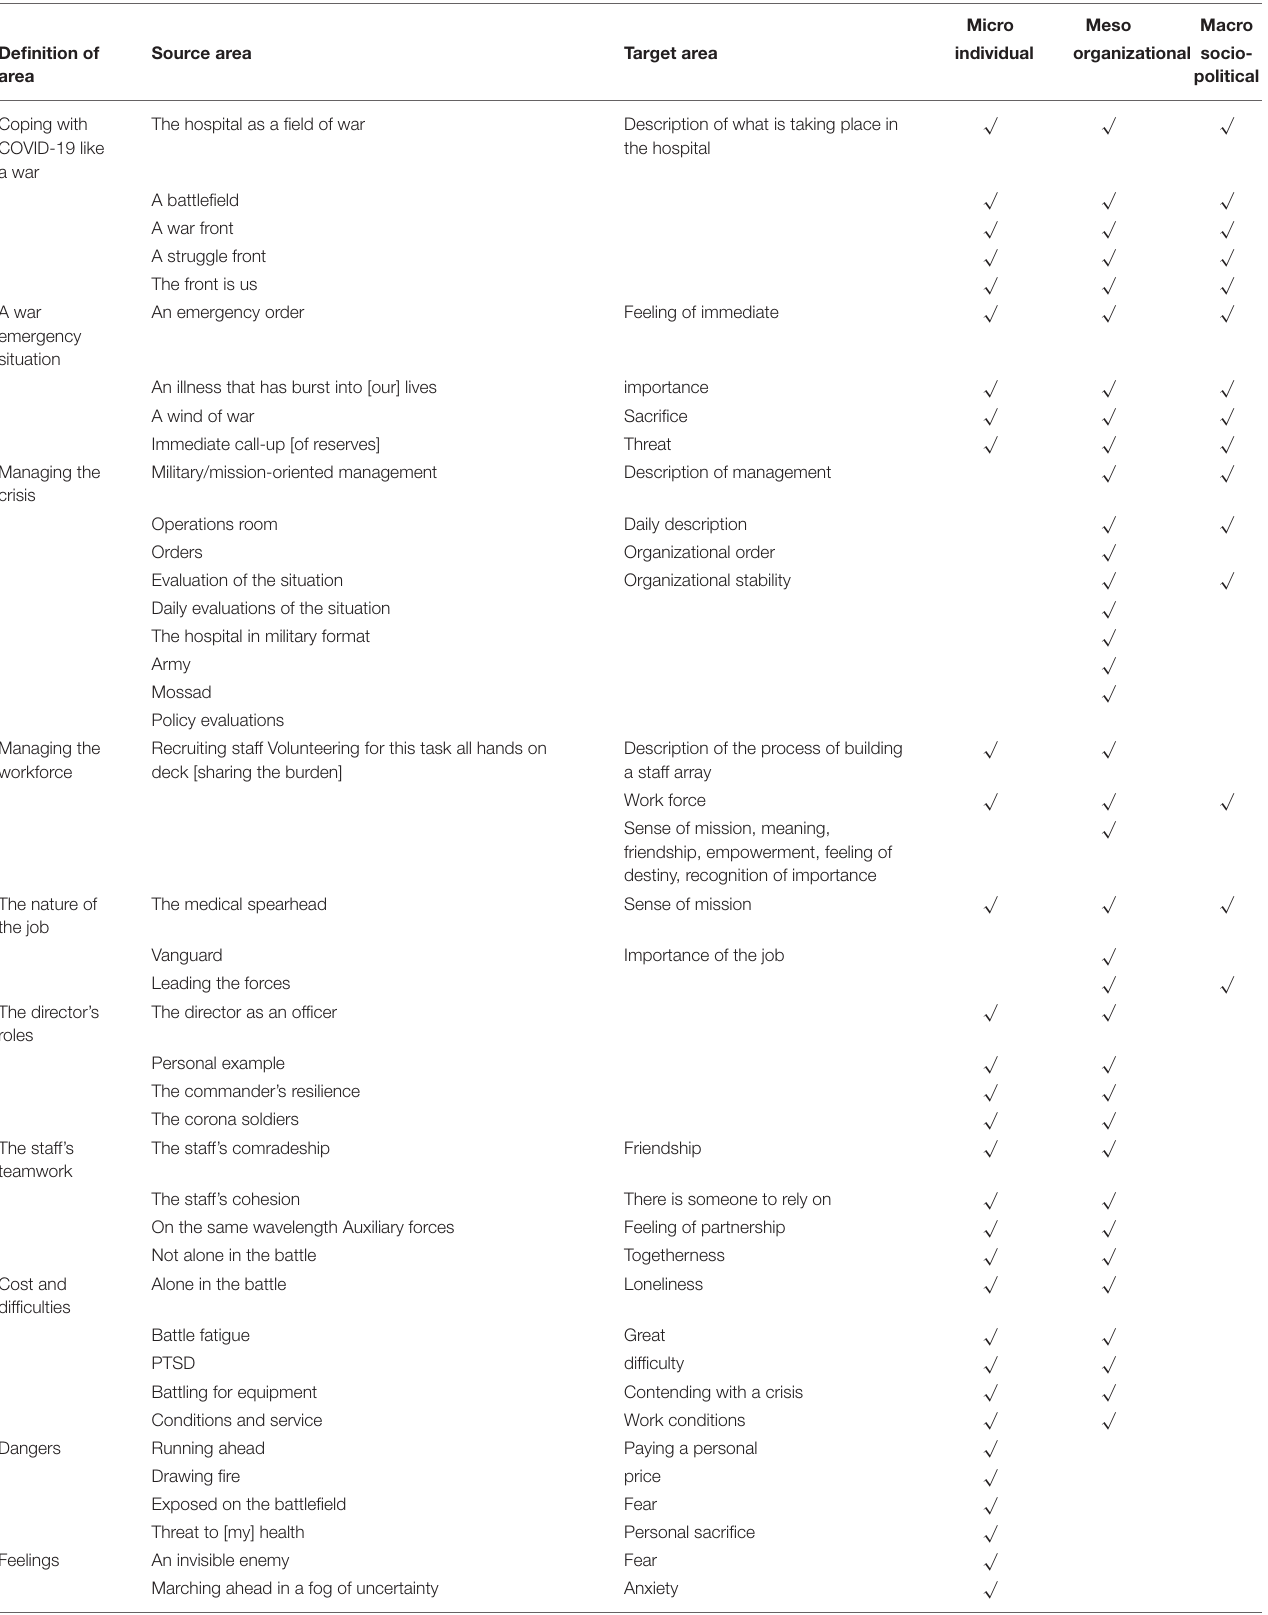
TABLE 1 | Main source areas and target